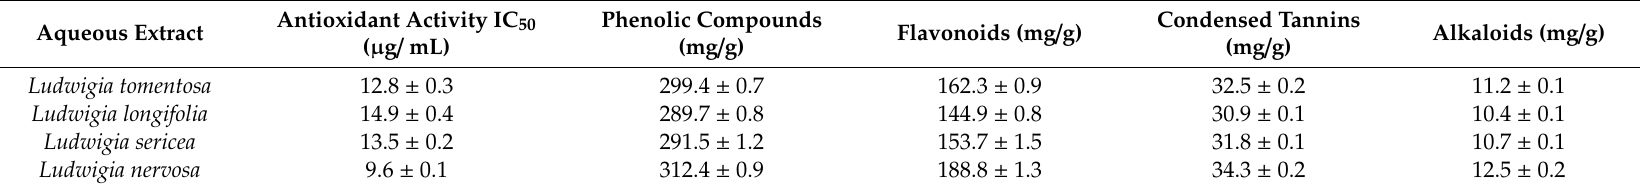
Table 3. Antioxidant activity data (IC 50 —minimum inhibitory concentration), phenolic compounds, flavonoids, condensed tannins and alkaloids of species of Ludwigia